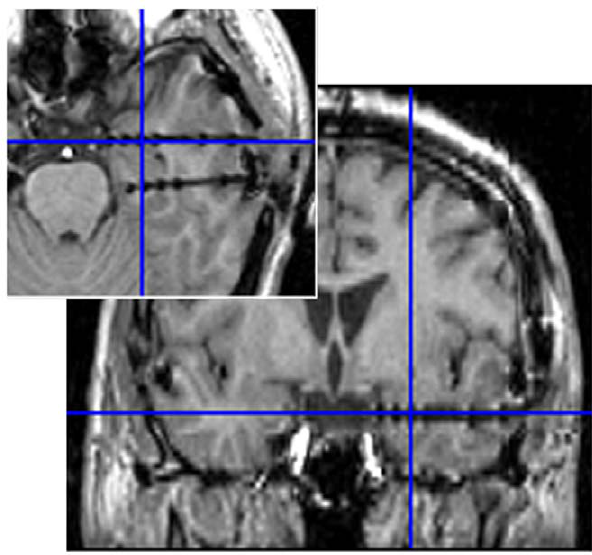
Figure 1. Representative anatomical magnetic resonance images. Blue crosses indicate the location of the amygdala electrodes.